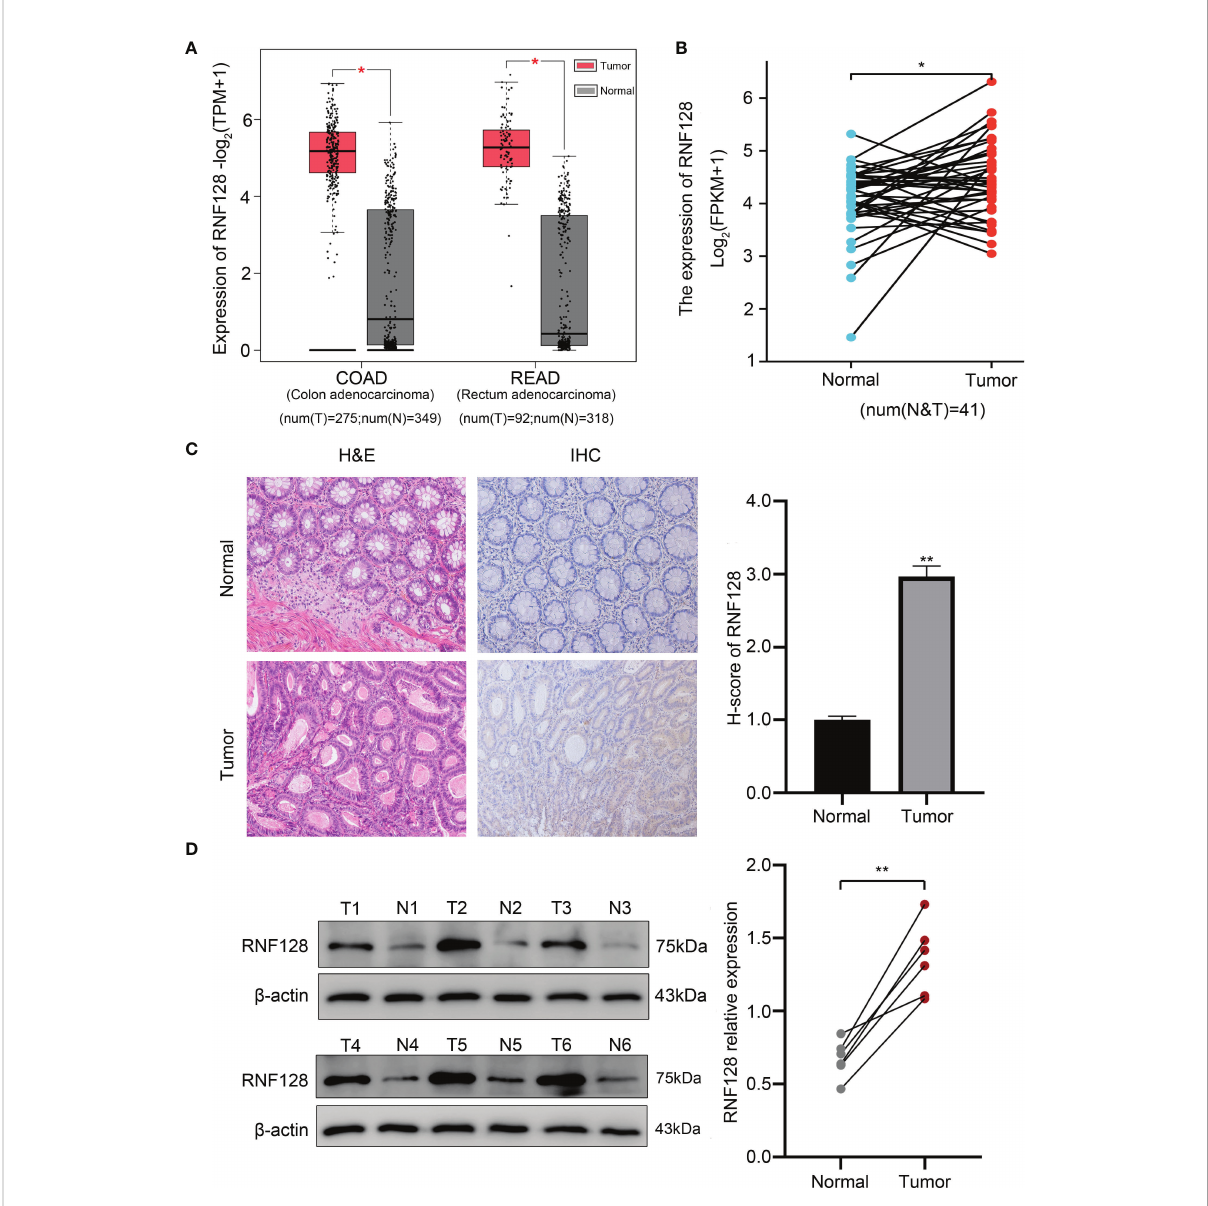
FIGURE 1 RNF128 is upregulated in colorectal cancer tissues. (A, B) The mRNA expression of RNF128 was evaluated in CRC datasets from the GEPIA and TCGA databases. (C) HE and IHC analysis of RNF128 expression in normal tissues and CRC tissues. (D) The protein levels of RNF128 in CRC tissues and normal tissues (n=6) were analyzed by western blot assays. * P <0.05, ** P